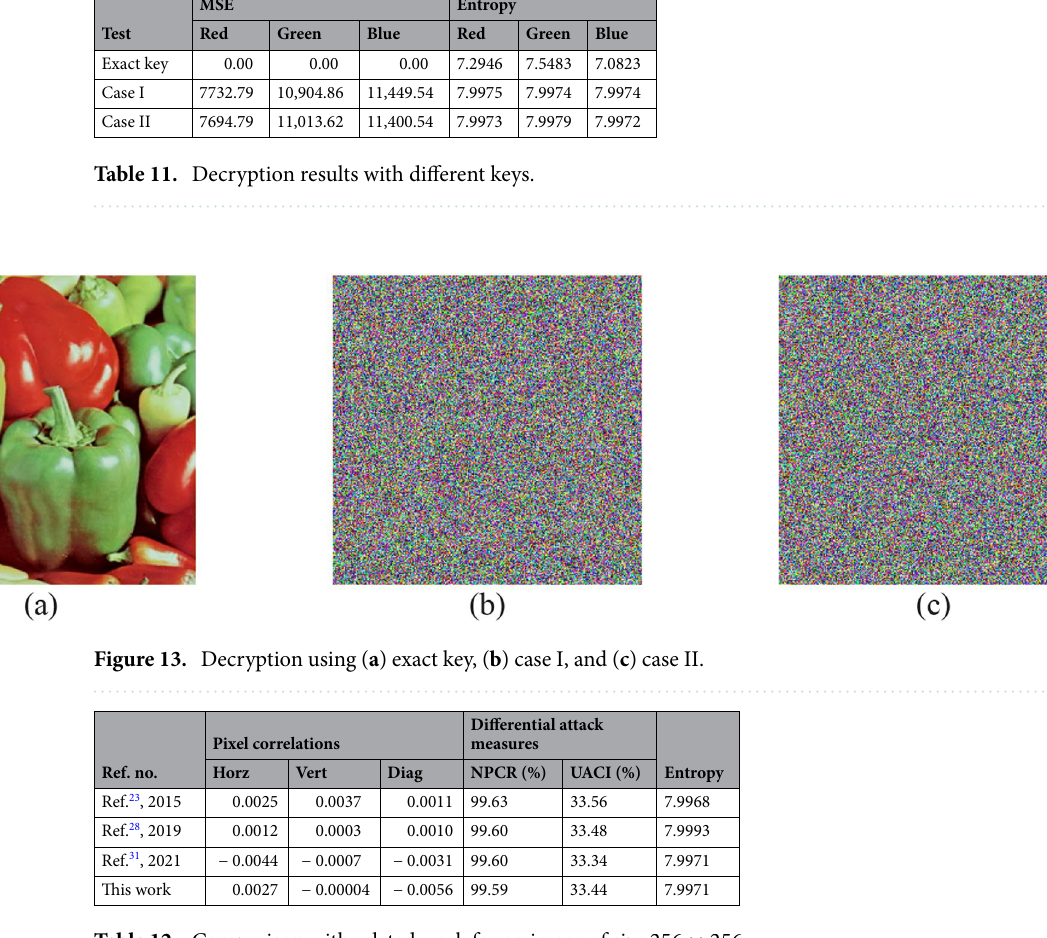
Table 12. Comparison with related work for an image of size 256